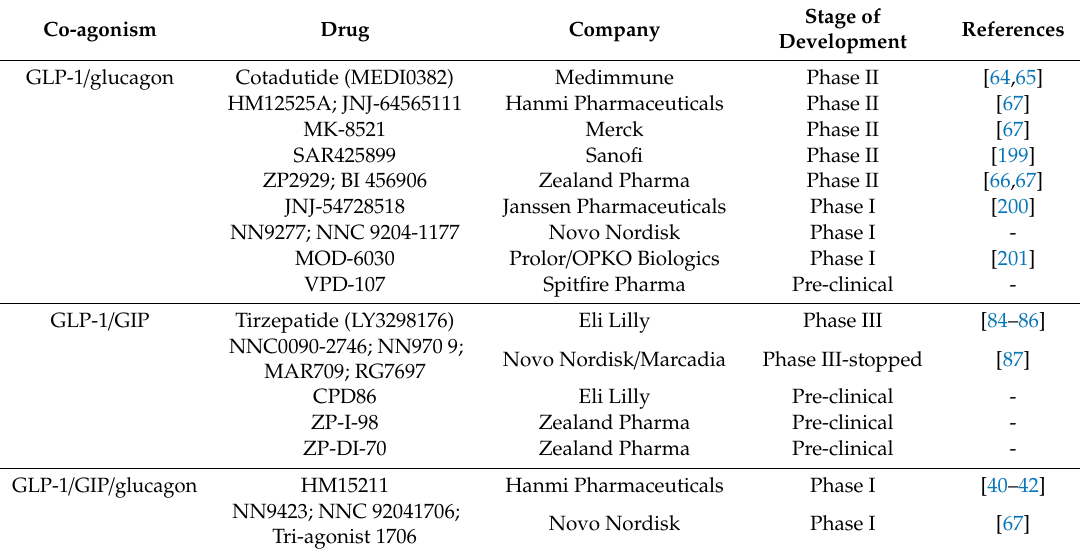
Table 3. Current GLP-1, GIP, and glucagon receptor co-agonists in development for treatment of T2D /